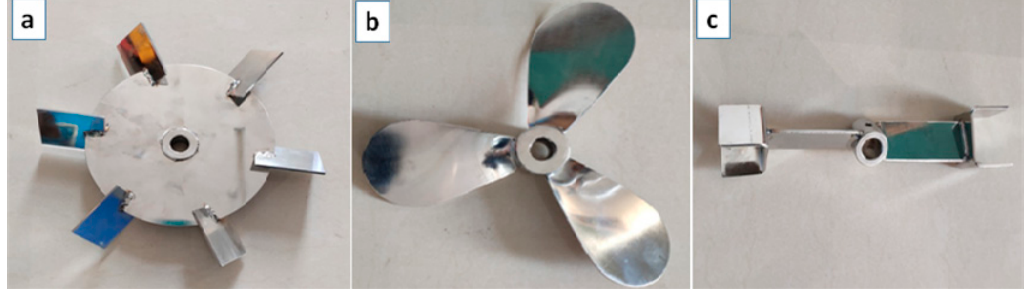
Figure 2. The diagram of the water model ( a —disc turbine impeller; b —propelling propeller; and c —Intermig